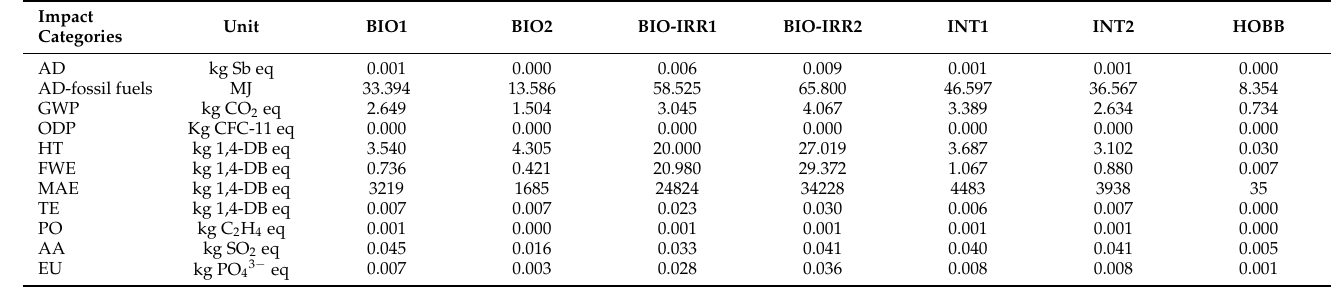
Table 4. Environmental impacts per litre of olive oil produced by each analyzed system (AD: abiotic depletion; AD-fossil fuels: abiotic depletion fossil fuels; GWP: global warming potential; PO: photochemical oxidation; ODP: ozone layer depletion; HT: human toxicity; FWE: fresh water aquatic ecotoxicity; MAE: marine aquatic ecotoxicity; TE: terrestrial ecotoxicity; AA: air acidification; EU: eutrophication).